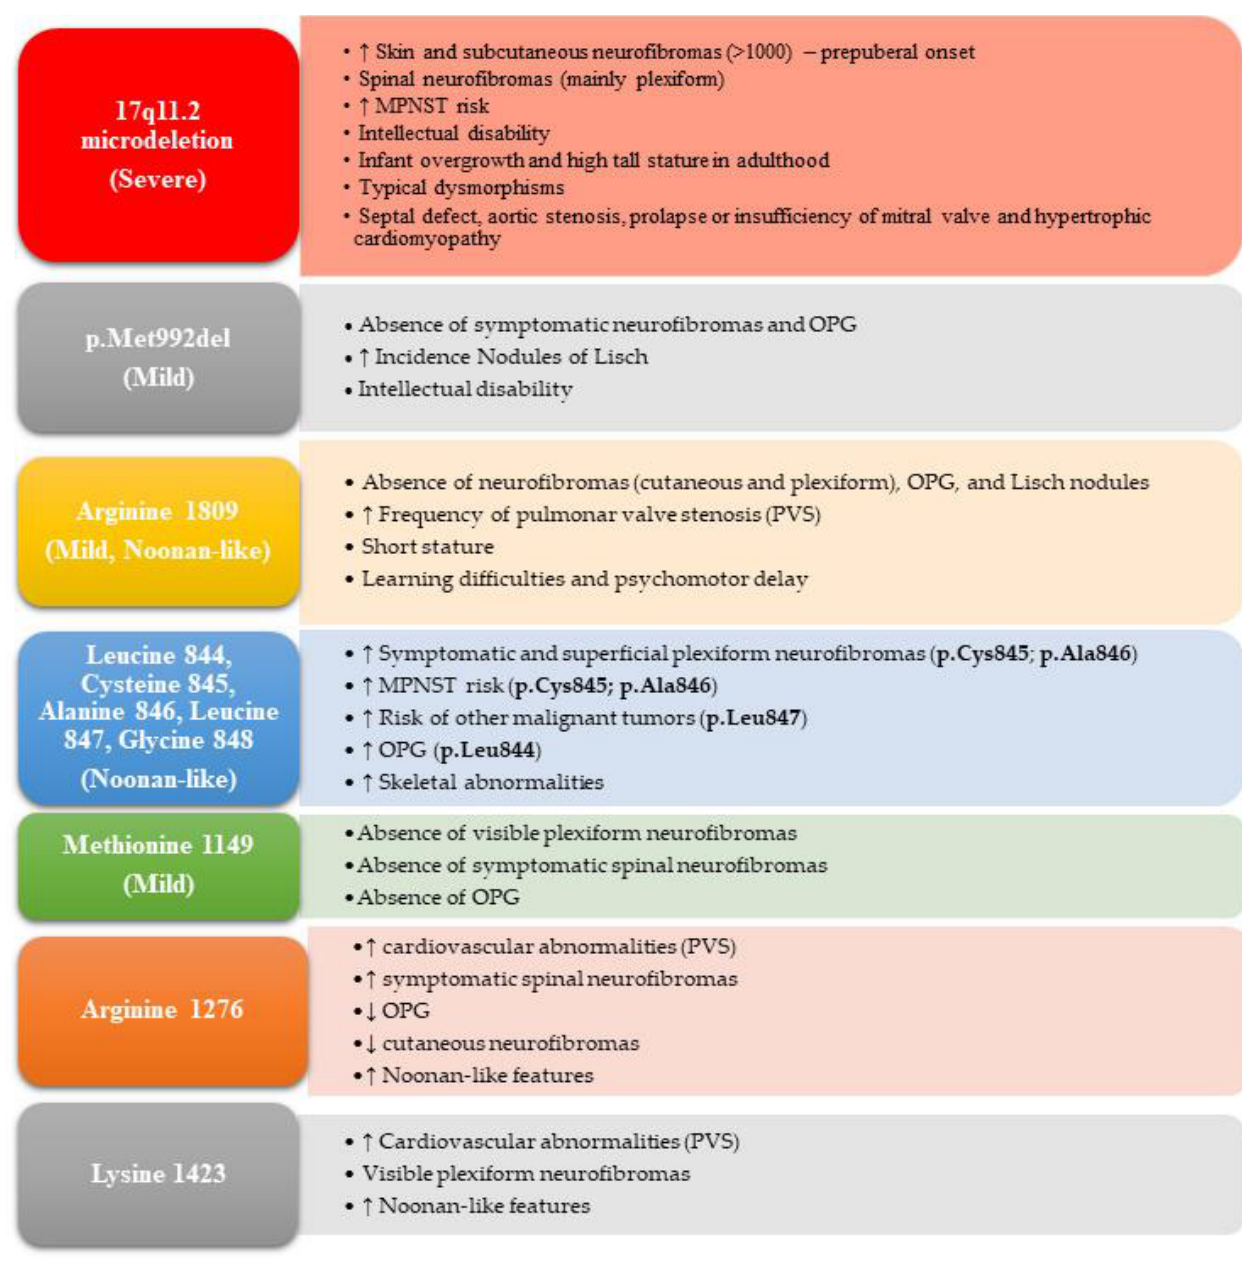
Figure 5. Genotype–phenotype correlations known to date for NF1 . Major phenotypic characteristics significantly more ( ↑ ) or less ( ↓ ) present, or possibly absent, are listed. Amino acid changes at specific positions are grouped according to the observed phenotypic features.